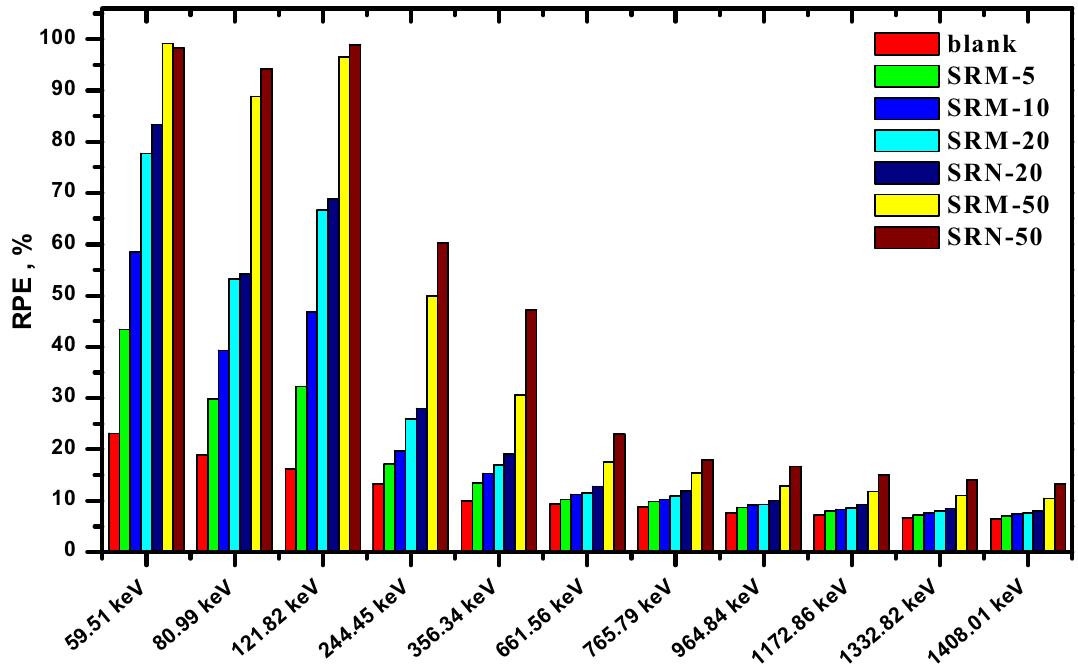
Figure 12. RPE of pure silicon rubber, micro, and nano PbO at different energy at thickness 1 cm.